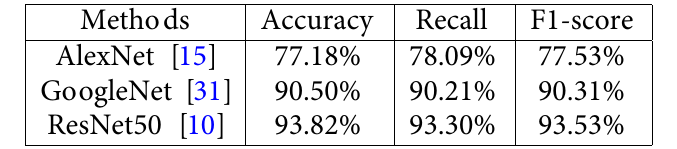
Table 1. Overall accuracy, recall and F1 scores of the trained CNN models for food category recognition with photos with the Food-11